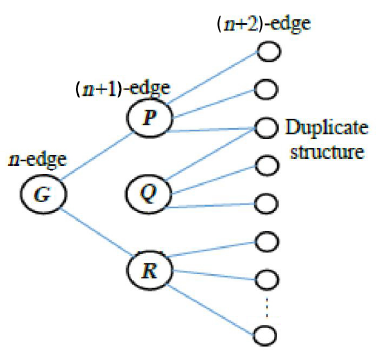
Fig. 12 DFS code [16] .